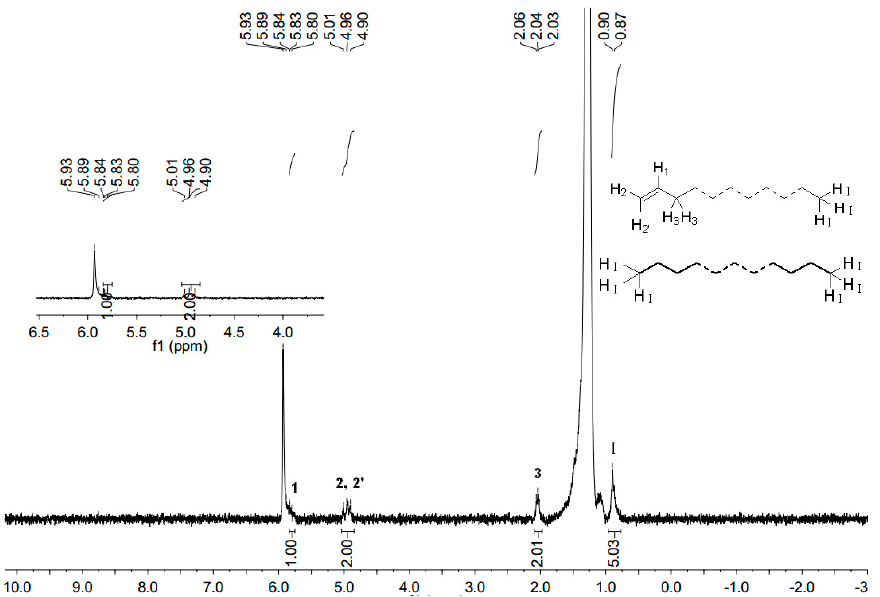
Figure 7. 1 H ‐ NMR spectrum of the polyethylene obtained using Co2 /MMAO at 50 °C (run 3, Table 3); recorded in 1,1,2,2 ‐ tetrachloroethane ‐ d 2 at 120 °C.